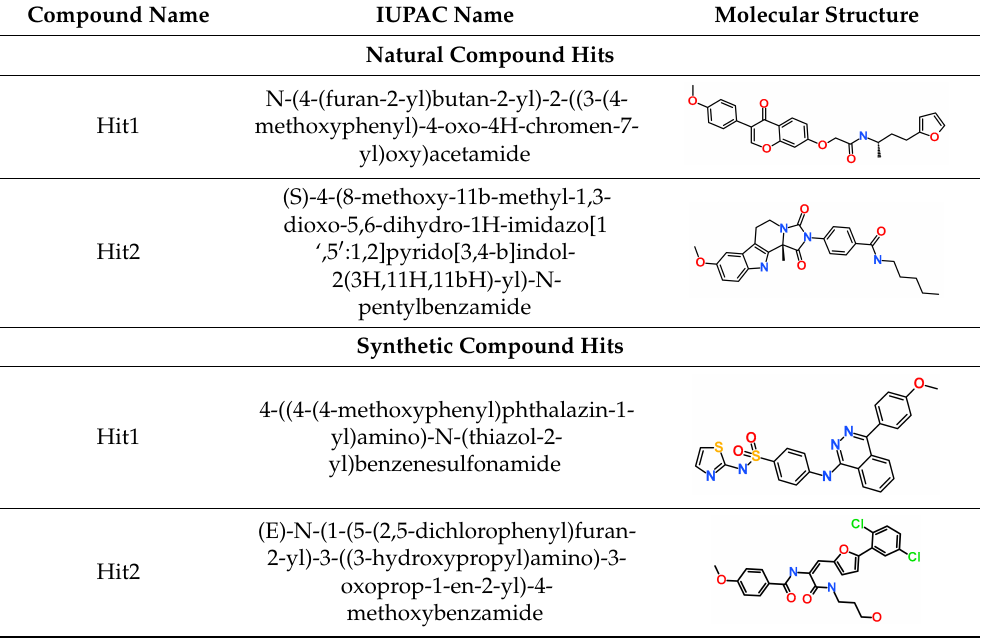
Table 7. Molecular structures and IUPAC names of identified hits from InterBioScreen